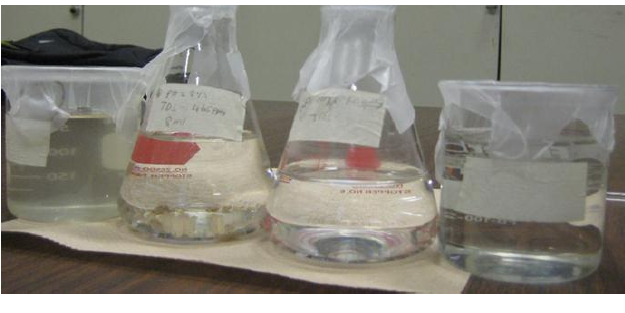
Figure 6. Lake water treatment processes, from left: untreated lake water, Alum coagulation treatment, coagulation/filtration, and direct filtration.